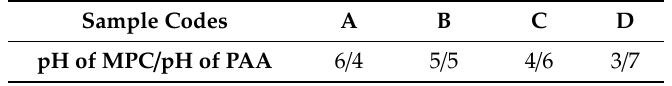
Table 1. Codes of di ff erent samples prepared at various pH